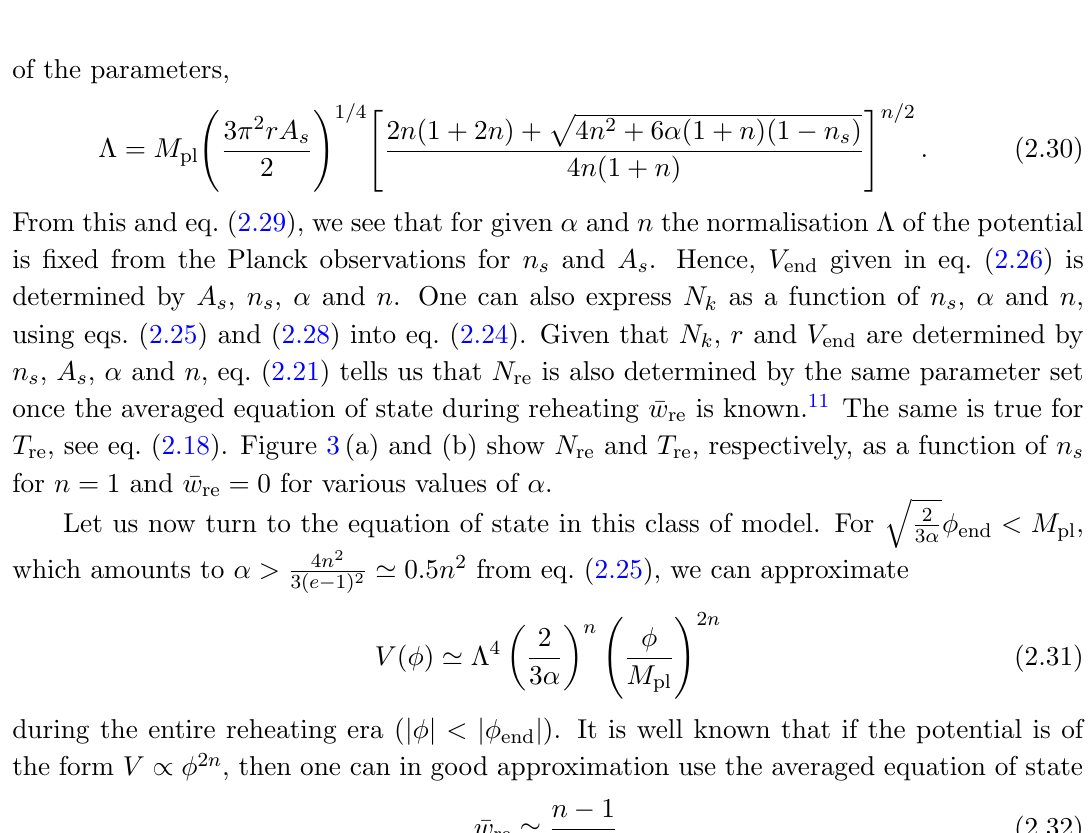
Figure 3. The spectral index dependence of N re (left) and T re (right) in (cid:11) -attractor E-model with n = 1 for various values of (cid:11) . We have taken (cid:22) w re = 0 and made use of Planck results [5] A s = 10 (cid:0) 10 e 3 : 094 . For T re we used eq. (2.18) with g (cid:3) = 100. The colour coding is used to denote di(cid:11)erent values of (cid:11)